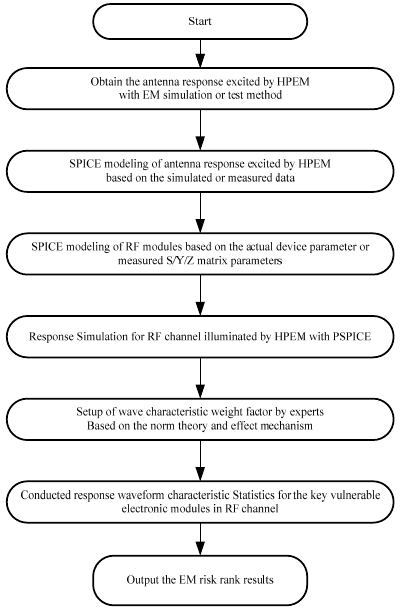
Figure 18. Flowcharts of EM risk assessment.